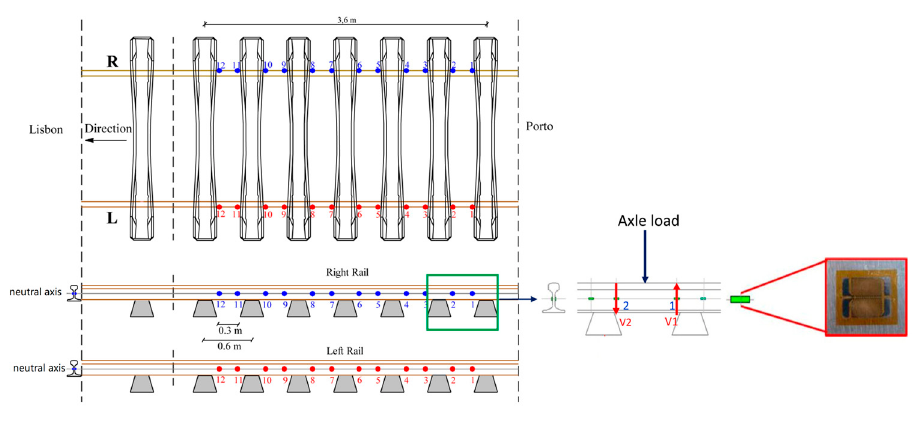
Figure 8. Strain gauges’ positions [80].